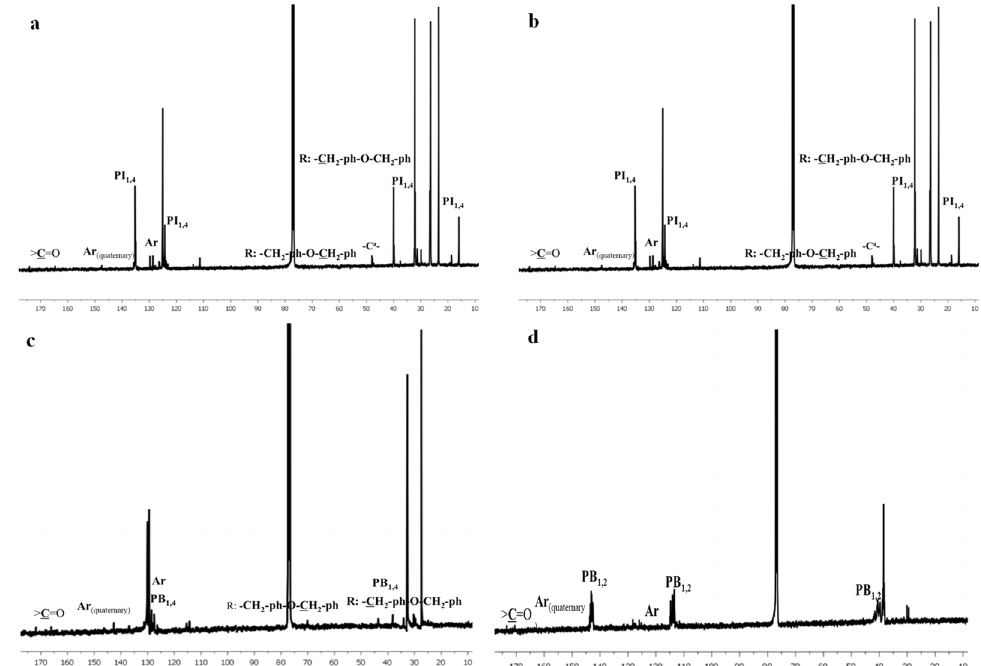
Figure 4. 13 C-NMR spectra of the synthesized materials corresponding to: ( a ) PI 1,4 - b -P(o-Bn-L-Tyr), ( b ) PI 3,4/1,2 - b -P(o-Bn-L-Tyr), ( c ) PB 1,4 - b -P(o-Bn-L-Tyr) and ( d ) PB 1,2 - b -P(o-Bn-L-Tyr).